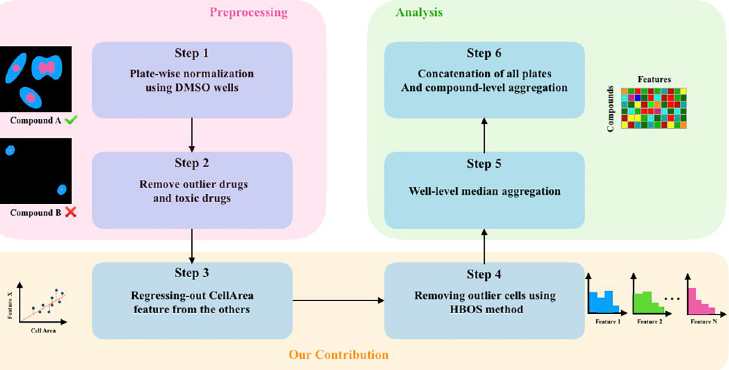
Fig 1. Representative workflow for the enhanced image-based cell profiling via data cleaning. Six main steps transform cell measurements of each plate to compound-level profiles. Specifically, in step 3, we replace each feature by part of those features that are accounted for by the cell area feature. This is achieved by regressing each feature against the cell area, and replacing each feature by the residue of the corresponding regression. Furthermore, cells that appear as outliers are identified and removed through a histogram-based approach, which is called HBOS, to make sure that the well-level aggregated profiles would not be affected by potential